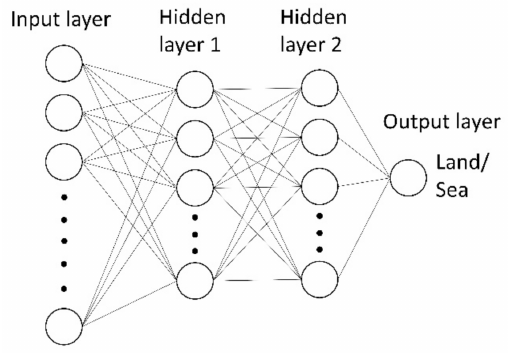
Figure 5. Structure of the present neural network model.